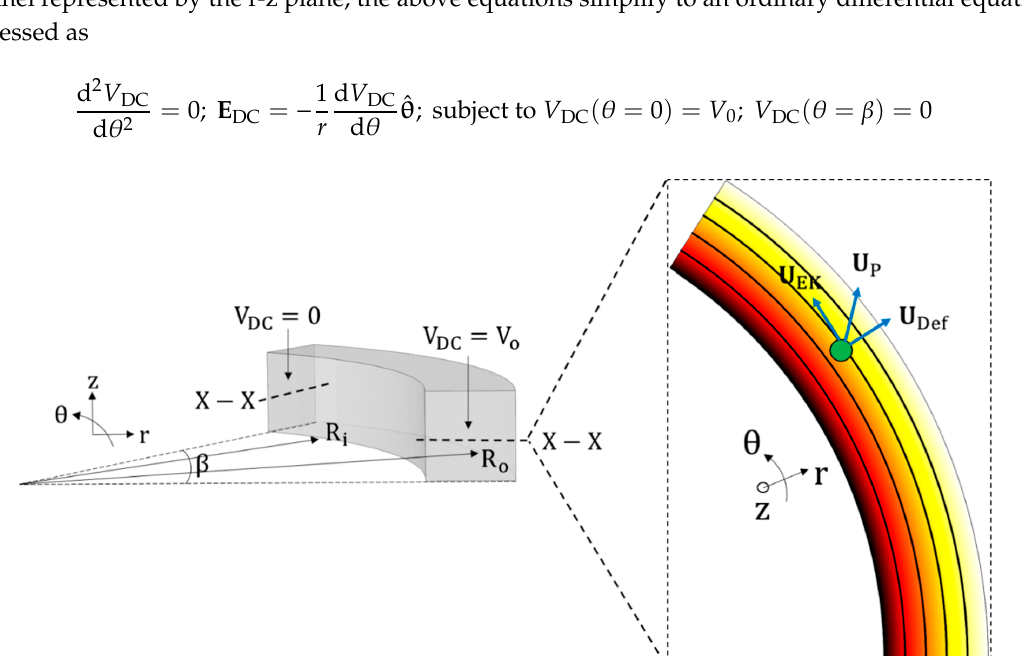
Figure 1. Schematic of a circular arc microchannel explaining the dimensions and the r- θ -z coordinate system, and framework used for a theoretical analysis of the underlying physics of curvature-induced dielectrophoresis (C-iDEP). The 2D projection of the r- θ section plane shows the components of the particle velocity, u P , inside the microchannel, consisting of the stream-wise electrokinetic ( u EK ) component and the cross-stream dielectrophoretic deflection ( u Def ) component. The electric field contour (the darker colour the larger magnitude) and lines (equivalent to the fluid streamlines [48]) are superimposed to explain the orientation of the velocity components relative to the electric field. A situation of negative DEP is shown, where the particle will move from the inner channel wall to the outer wall. For a positive DEP, the resultant velocity and the deflection component will reverse their directions. Note that the underlying physics of C-iDEP are two dimensional because of the application of the voltage over the entire r-z